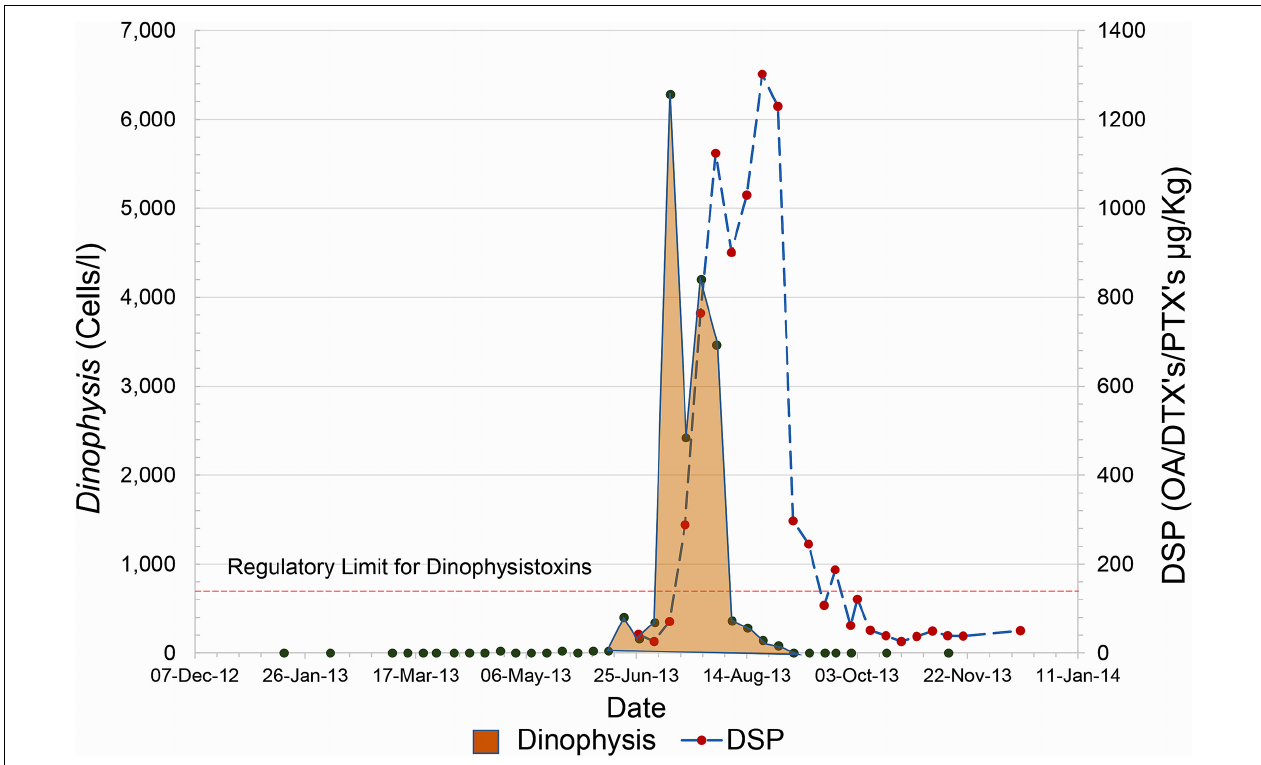
FIGURE 1 | An example of the rapid rise of Dinophysis and associated toxins that occurred during the summer of 2013. The plot shown represents the evolution of the bloom in the site, East of Linga, however, this rapid increase was mirrored in sites along the West coast of the Shetland